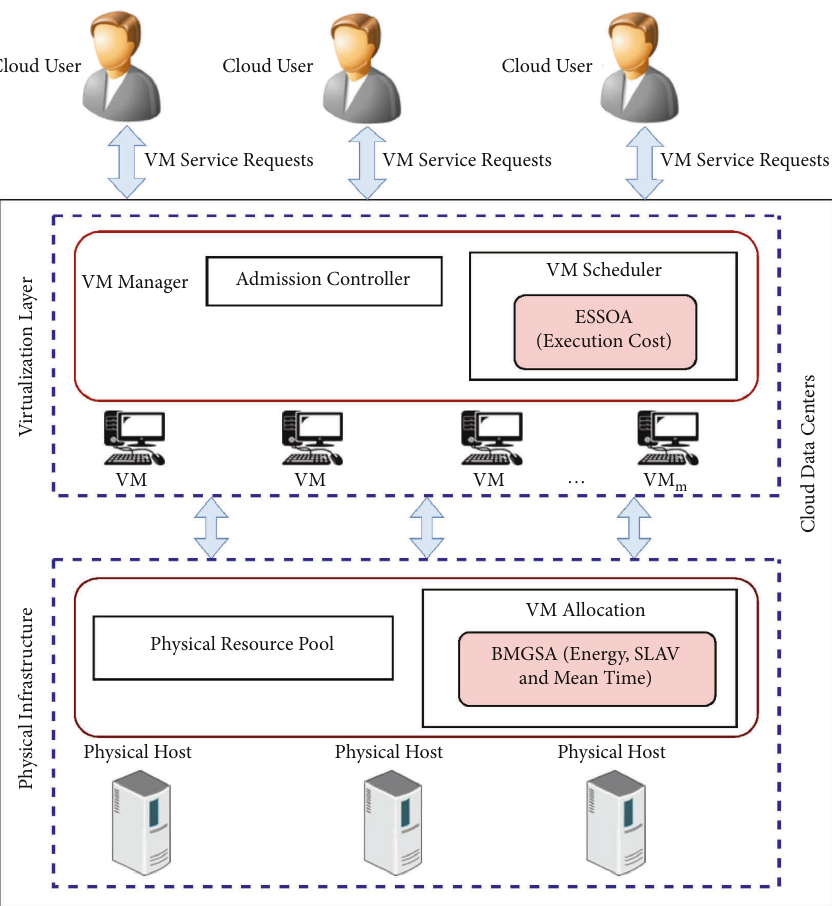
Figure 2: Proposed